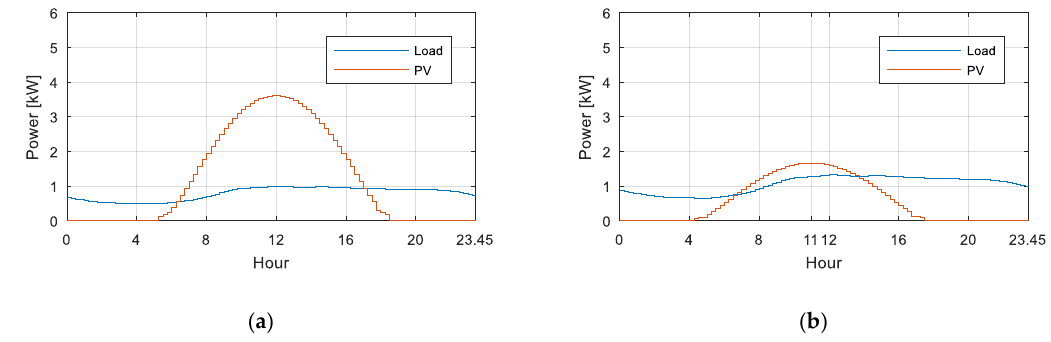
Figure 6. Load profile and PV generation for a prosumer example, for the days along a year with: ( a ) highest total radiation and ( b ) lowest total radiation.